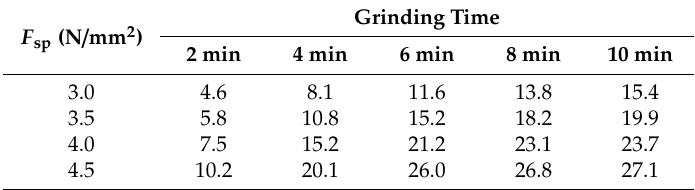
Table 7. Values of average reduction ratio (S50) for HRC products.